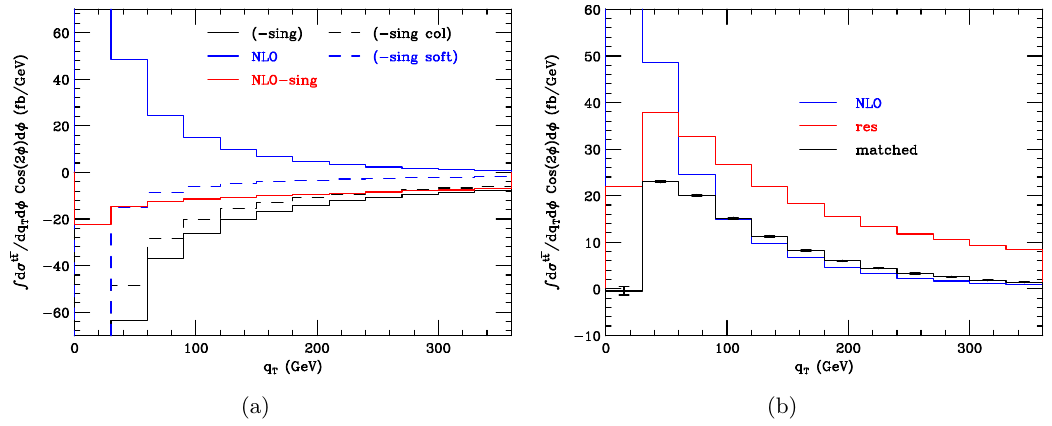
Figure 3 . Transverse-momentum spectrum d(cid:27) n =dq T for the n = 2 harmonic in t (cid:22) t production. In the left panel the exact NLO result (blue) is compared to the 1 =q 2 singular component (black), T which is split in its collinear (black dashed) and soft (blue dashed) parts. The singular components are plotted with opposite overall sign. The (cid:12)nite result (NLO-sing) that is obtained by subtracting the singular component from the exact NLO result is also shown (red). In the right panel the NLO result (blue) is compared to the purely resummed result (red) and to the complete matched result (black), computed as described in the